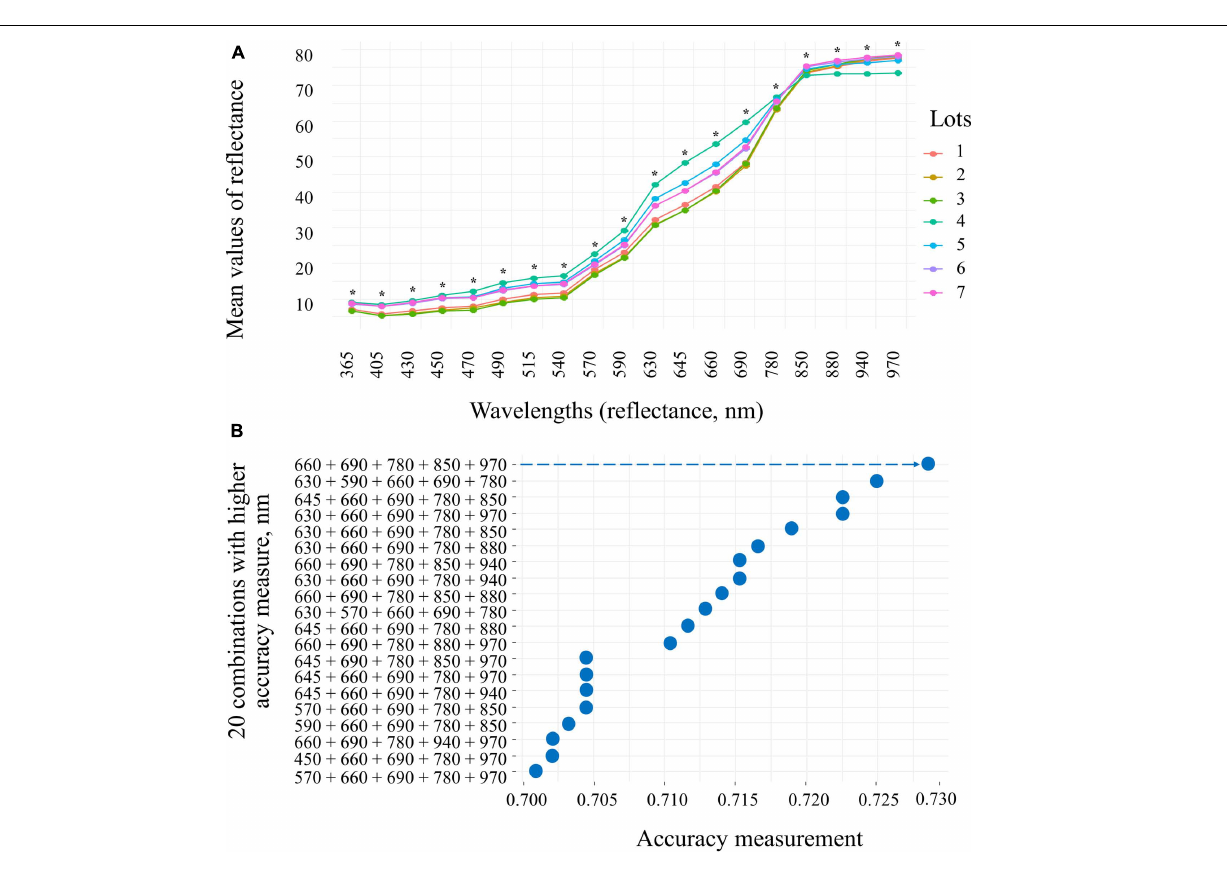
Frontiers in Plant Science |